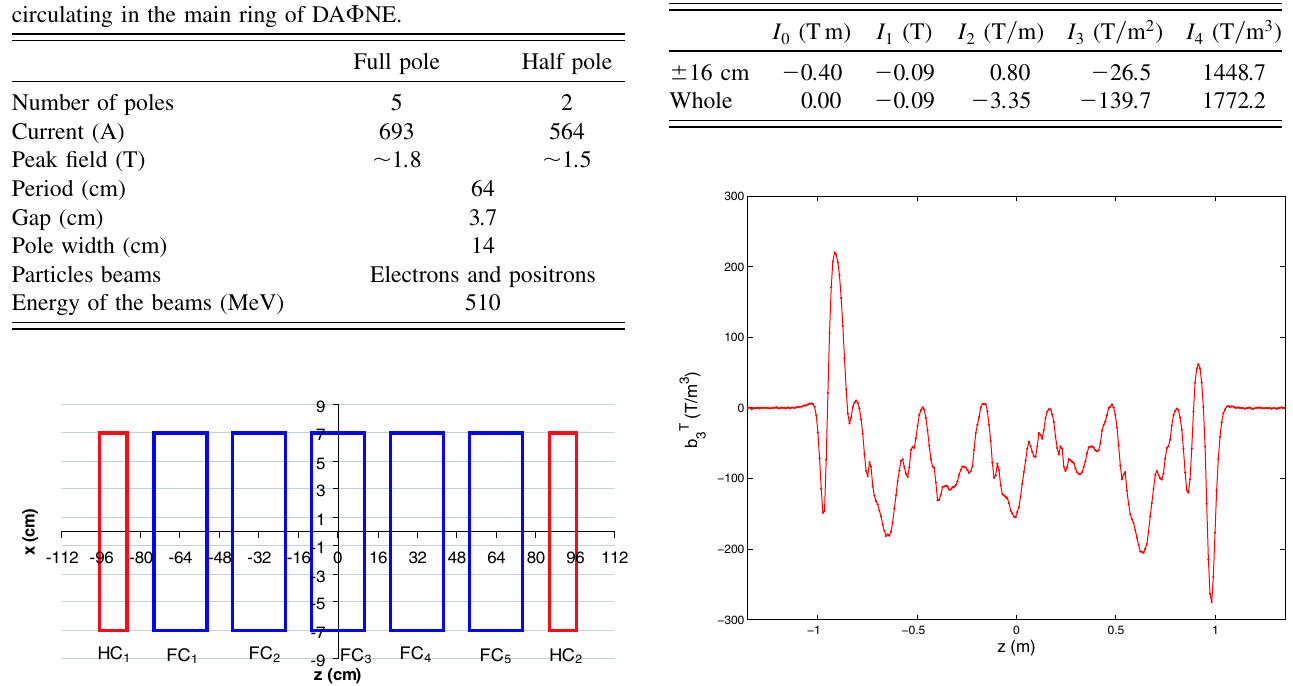
TABLE II. Present situation: integrated coefficients of the transversal expansion of the magnetic field in the central semi- period and in the entire wiggler.